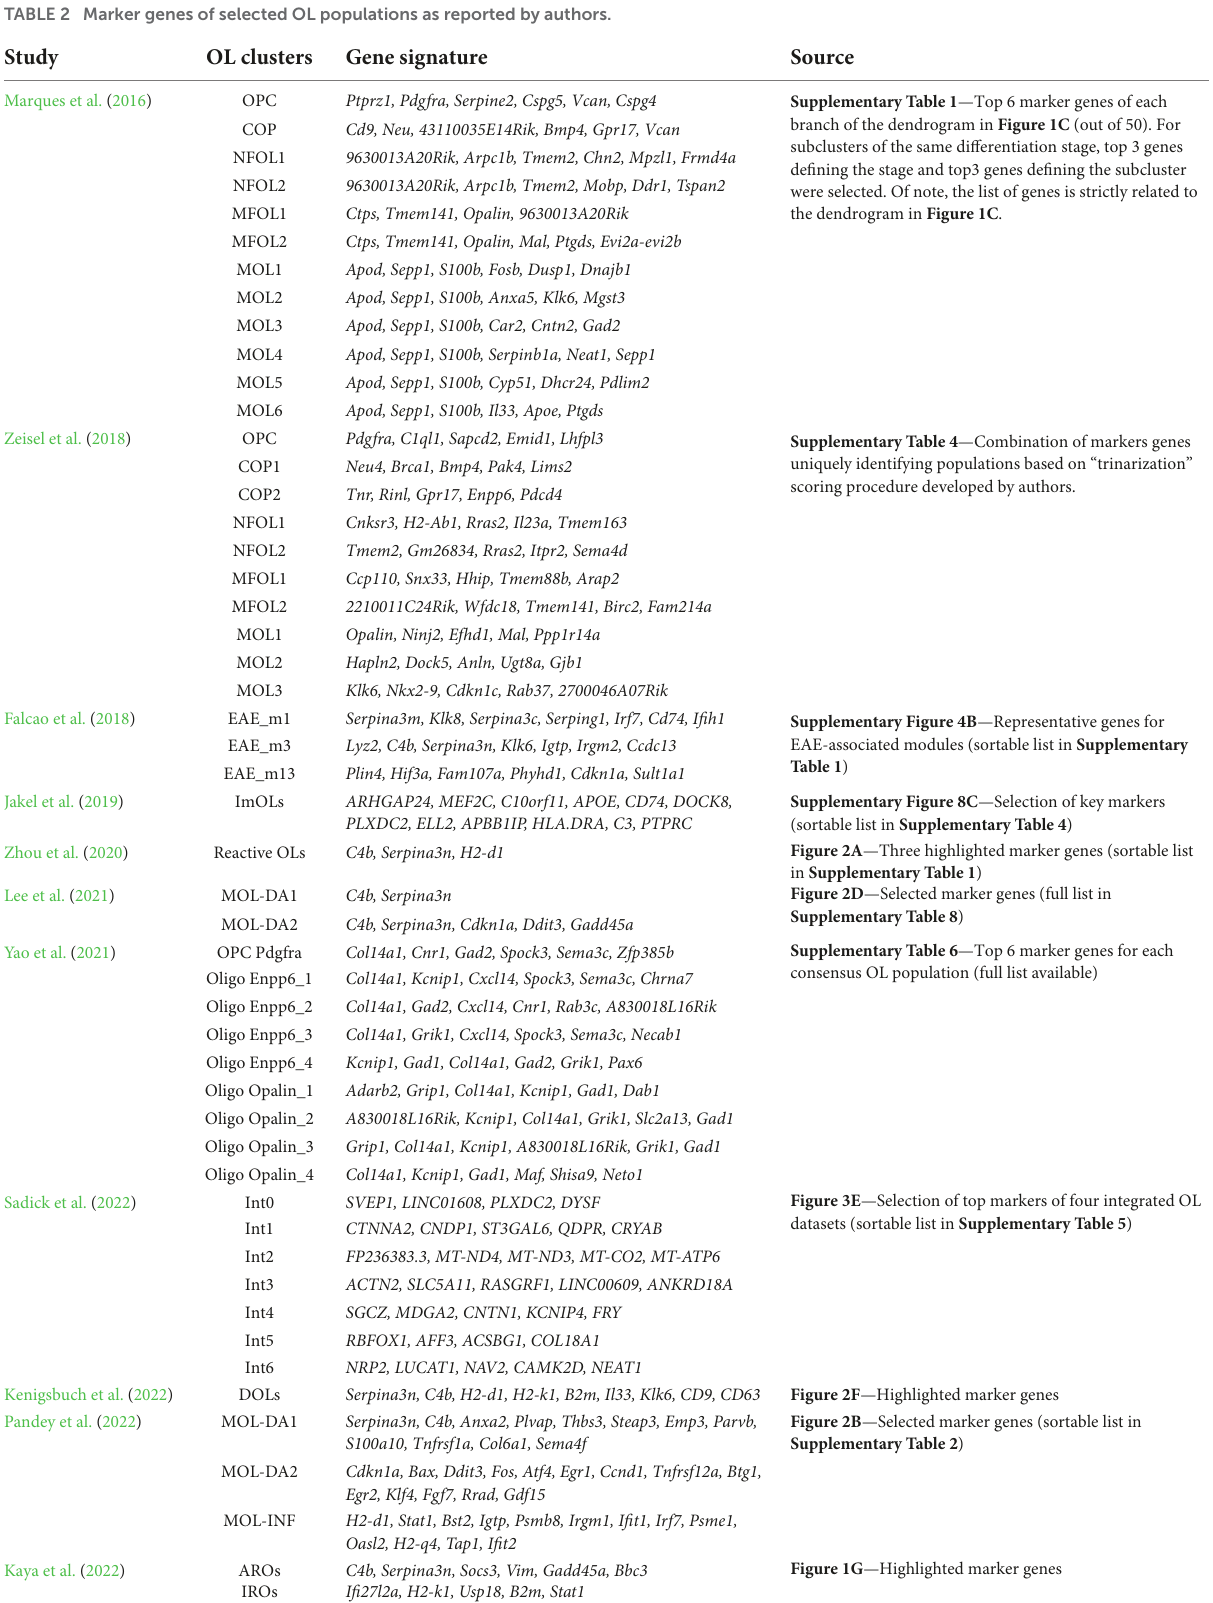
TABLE 2 Marker genes of selected OL populations as reported by authors.